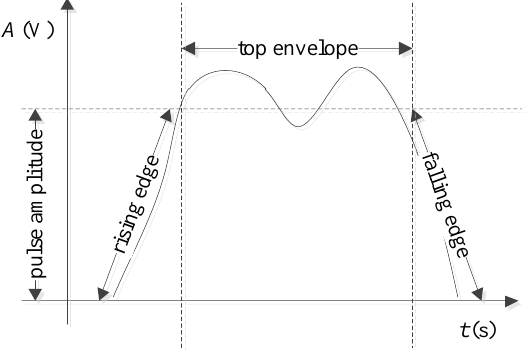
Figure 2. A typical envelope of a pulsed signal.